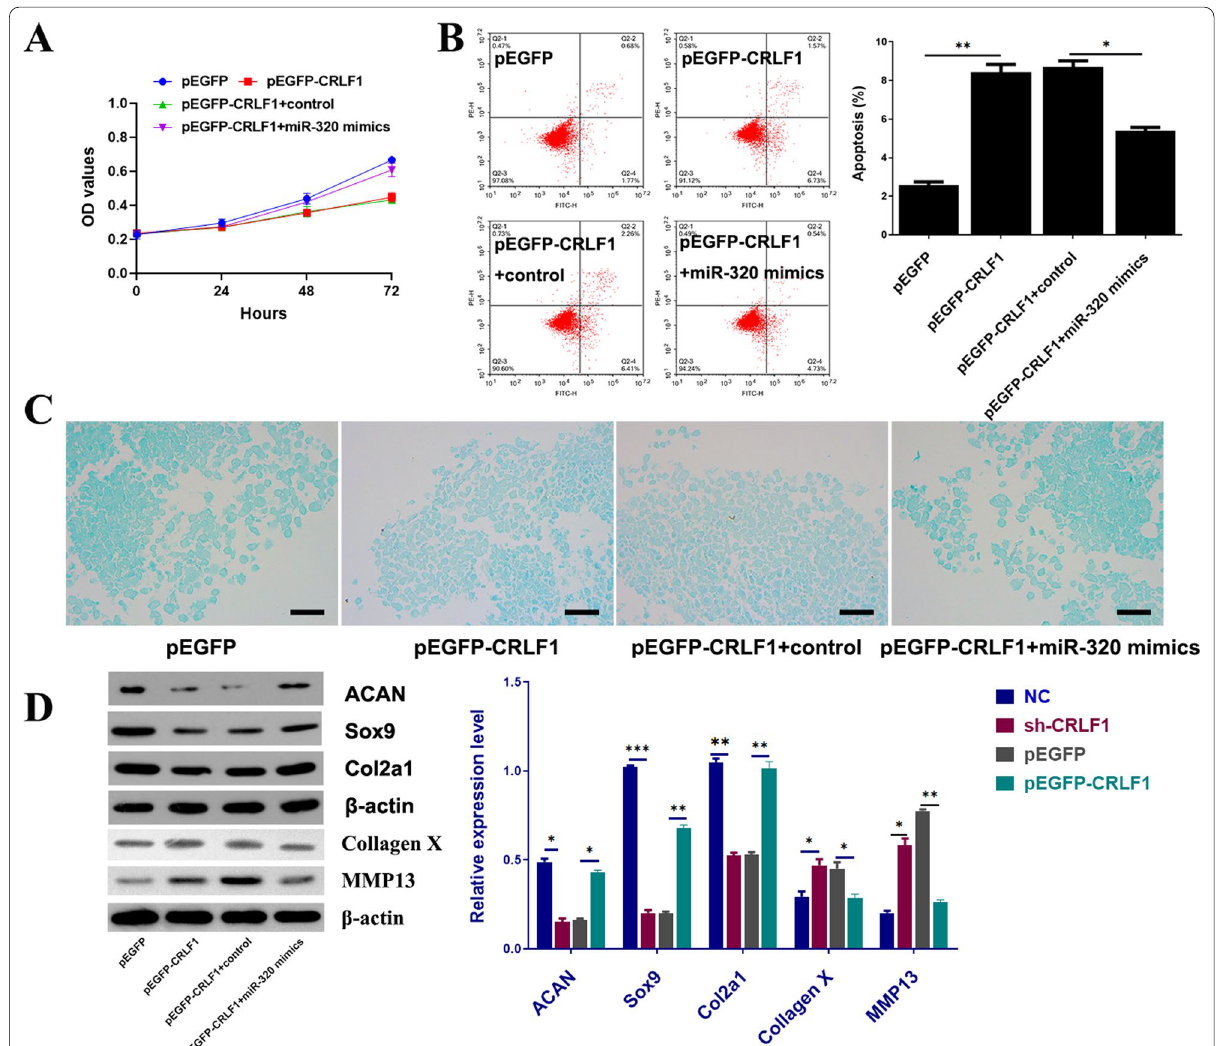
Fig. 5 miR-320 could reverse the effect of CRLF1 on cell proliferation, apoptosis and chondrogenic differentiation of BMSCs. A Cell viability was estimated in BMSCs co-transfected with pEGFP-CRLF1and miR-320 mimic. B Apoptosis was examined by flow cytometric analysis using Annexin V/PI assay. C The deposition of cartilage matrix proteoglycans was determined by Alcian blue staining (scale bar, 50 μm). D Protein expressions of ACAN, Sox9, Col2a1, collagen X and MMP13 were analyzed by western